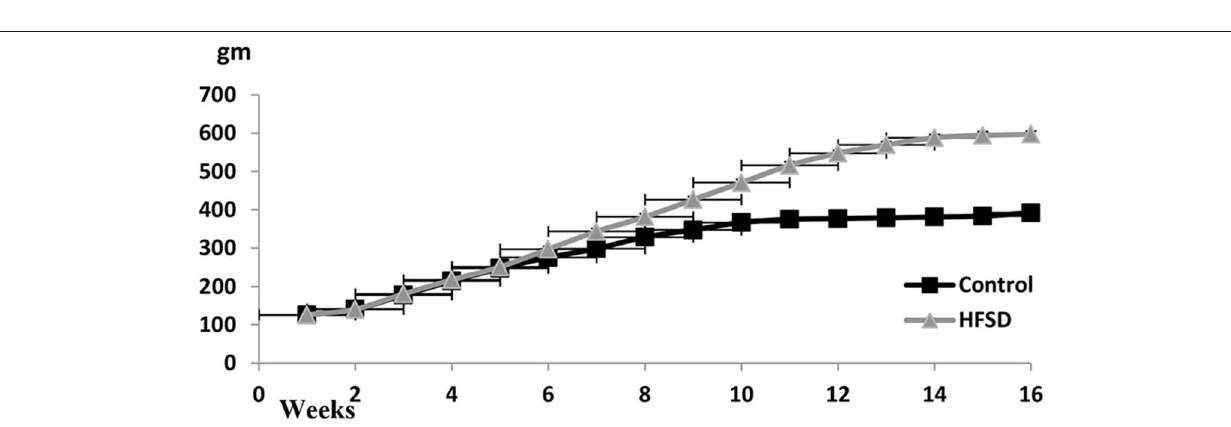
prediabetics, and P = 0.007 in diabetics, F (3,36) = 29.13] compared to those in the untreated prediabetic